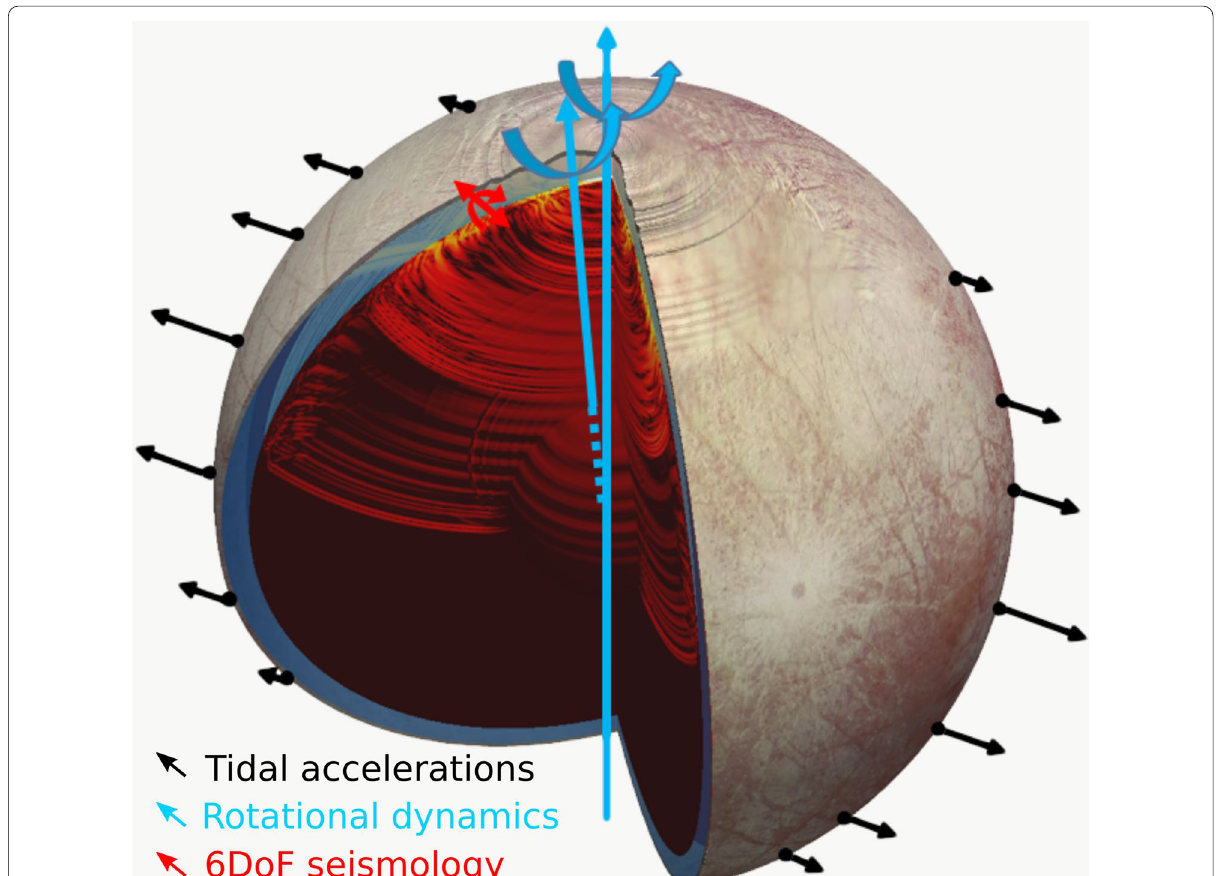
Fig. 1 Schematic illustration of the phenomena to be observed with the PIONEERS instruments at one point at the surface of a celestial body. Ground motions during passage of a seismic wave field in 6DoF (red arrows) as well as rotational motions induced by the body’s rotational dynamics (e.g., librations, blue arrows) and translational motions induced by tidal forces (black arrows) are the target observables. Here, Jupiter’s icy moon Europa is shown as an